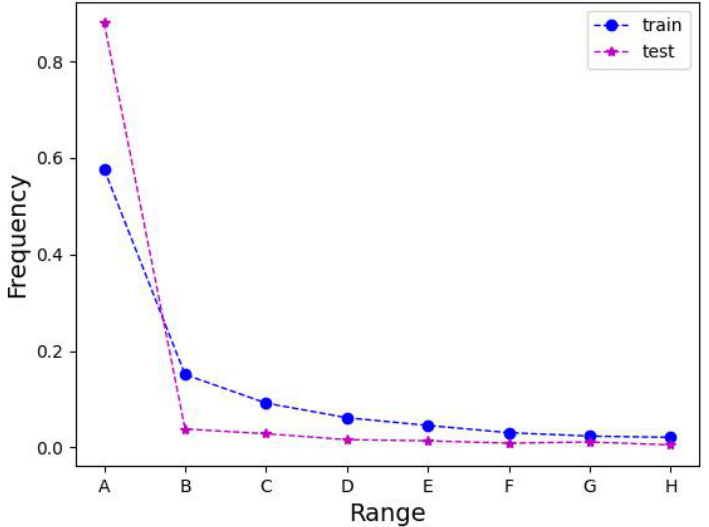
Figure 12. The folding chart of the percentage of different regions in the DSIFN-CD